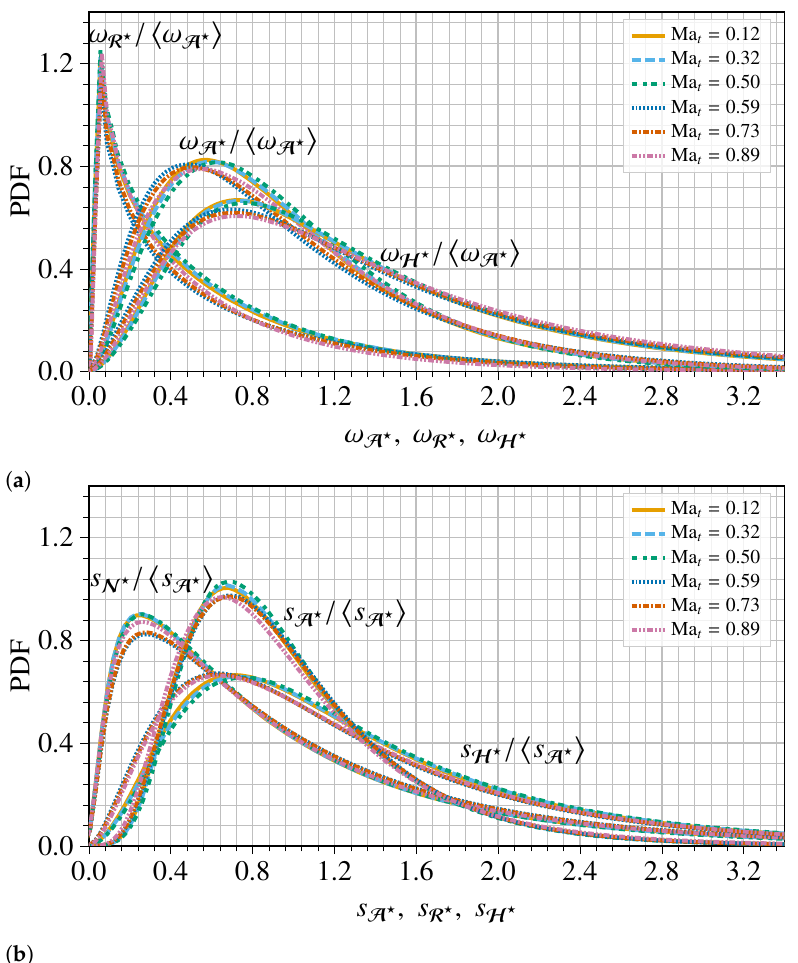
Figure 9. PDF of ω A (cid:63) and s A (cid:63) and their components ( a ) ω H (cid:63) , ω R (cid:63) , ( b ) s H (cid:63) and s N (cid:63) for six different Ma t . The sampling of the data prior to the PDF computation has considered the clipping of the zero values of ω R (cid:63) .